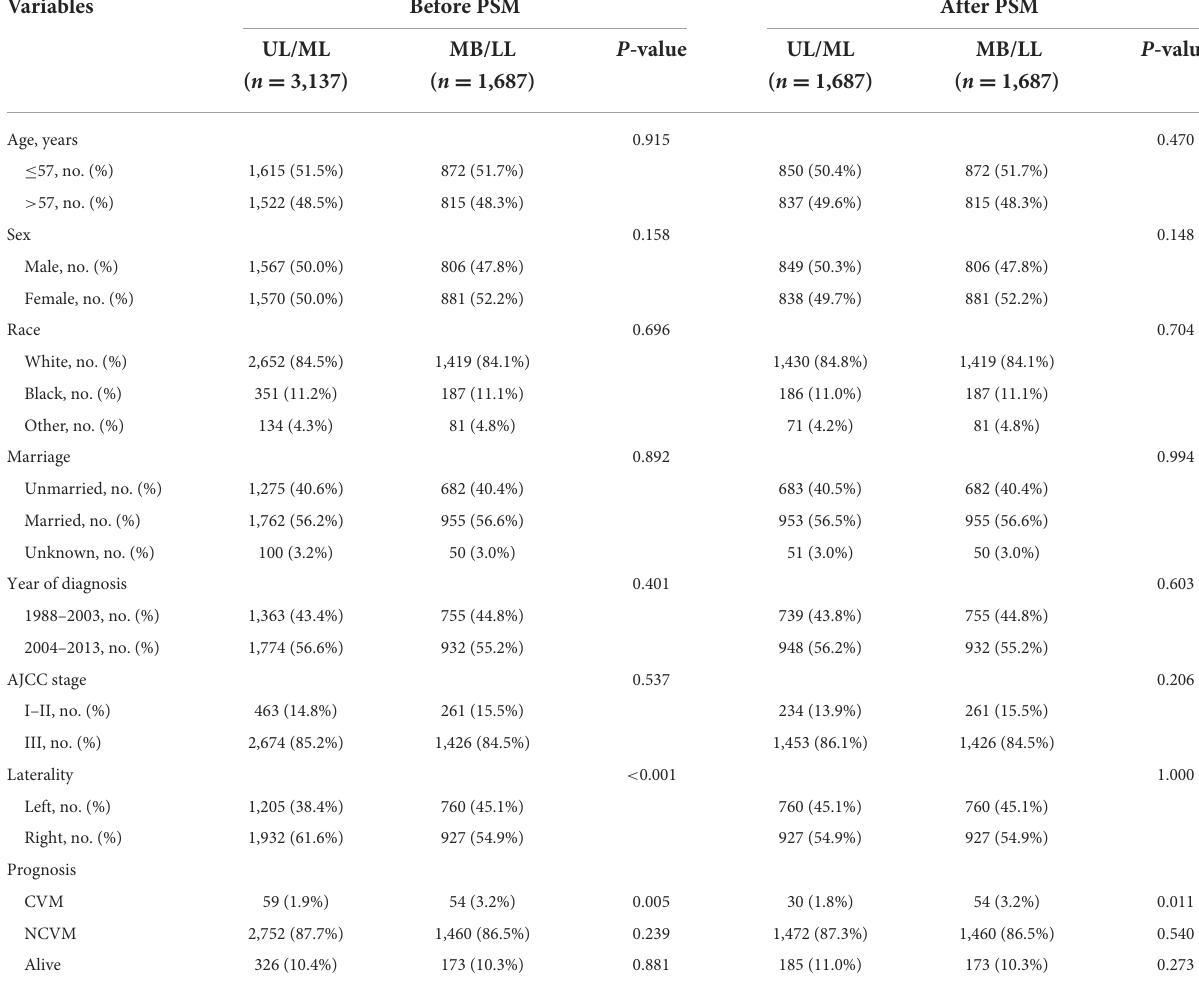
TABLE 3 The baseline clinical and prognostic characteristics of LS-SCLC patients stratified into UL/ML and MB/LL groups by primary site before and after PSM. Variables Before PSM